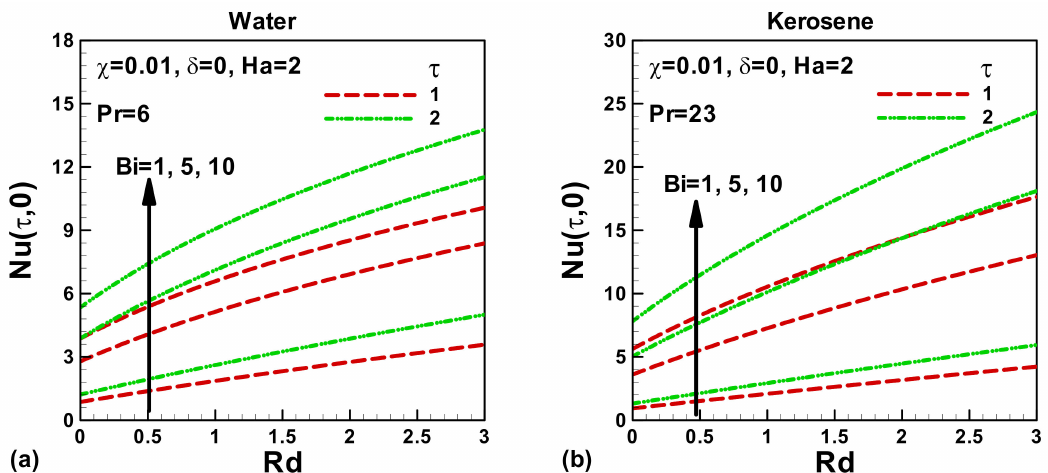
Figure 6. E ff ects of Biot number Bi, dimensionless time τ , and radiation parameter Rd on Nusselt number for ( a ) water and ( b ) kerosene oil as base